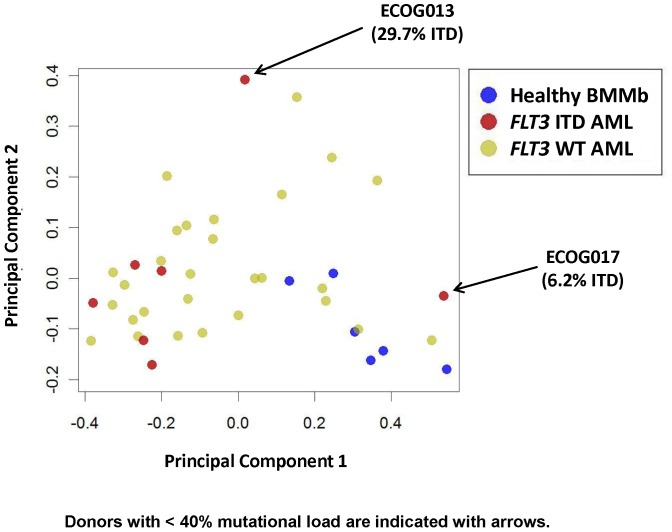
PCA pathway analysis of FLT3 ITD AML samples and healthy BMMb compared to FLT3 WT AML.PCA analysis of FLT3L-induced signaling (PC 1) and AraC/Daunorubicin-induced apoptosis measured by cPARP (PC 2) in healthy BMMb (blue dots), FLT3 ITD (red dots) and FLT3 WT (green dots). Donors with low FLT3 ITD mutational load (<40%) are indicated by arrows.